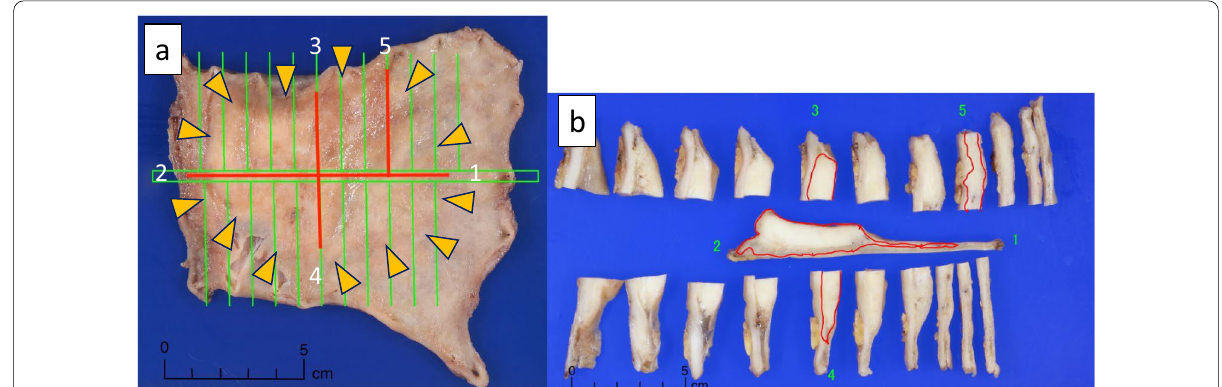
Fig. 1 a Macroscopic findings of the resected gastric lesion specimen at the time of the first surgery(1: proximal site, 2: distal site). The green line is the dividing line at the time of pathology specimen preparation. Poorly differentiated adenocarcinoma was identified in the area of the red line. Together with the macroscopic view, the area indicated by the arrow is presumed to be the tumor. b The lesion is located in the area indicated by the red line. Histologically, the lesion was extensively found along the submucosal layer (red line). The margins were negative